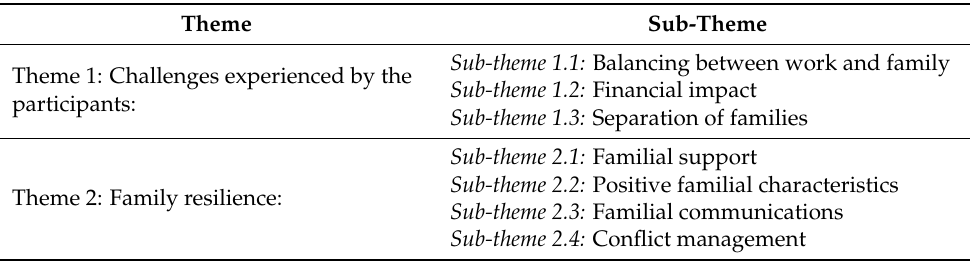
Table 2. Themes and